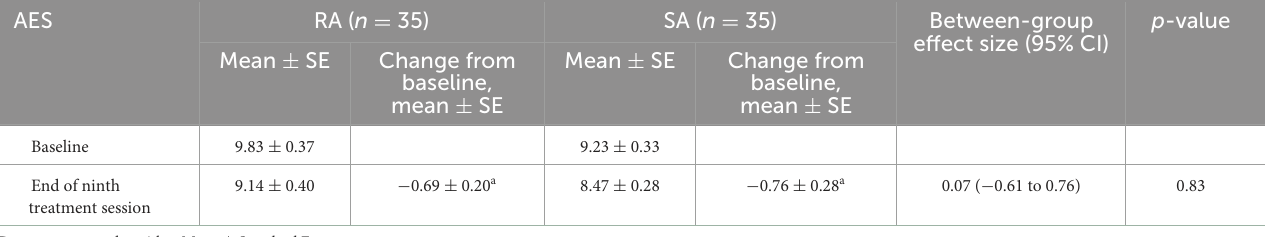
TABLE 11 AES outcome across trial time-points (ITT dataset, participants =